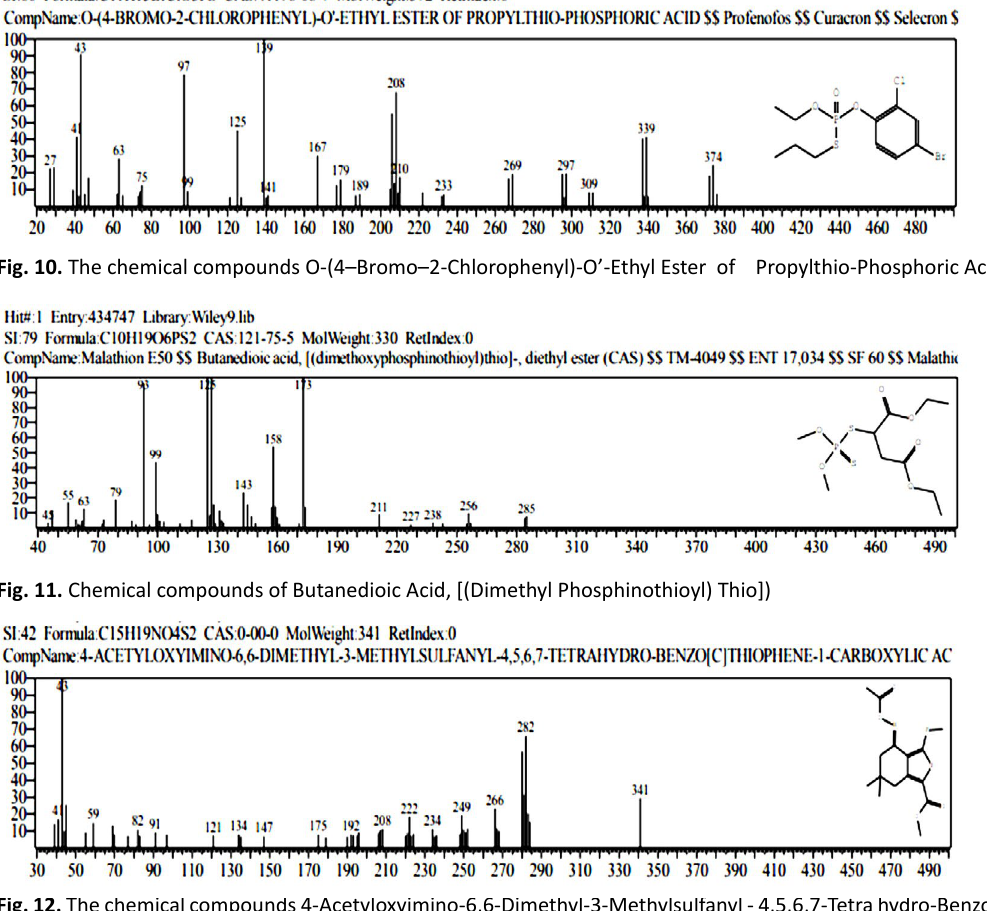
Fig. 12. The chemical compounds 4-Acetyloxyimino-6,6-Dimethyl-3-Methylsulfanyl - 4,5,6,7-Tetra hydro-Benzo